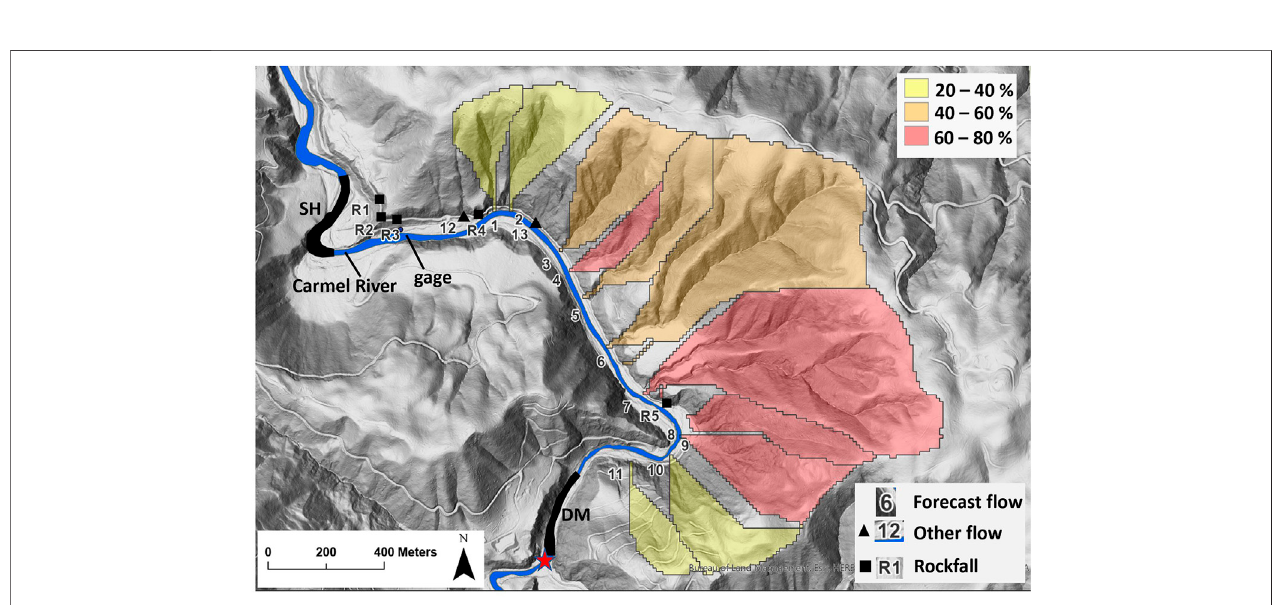
FIGURE 4 | Shaded relief map of debris fl ow study site. Eleven colored regions are watersheds with USGS debris fl ow likelihood (% chance), given a peak 15 min duration rainfall intensity of 24 mm/hr (USGS 2020). DM and SH are the long-term gravel sampling sites located upstream and downstream, respectively, of the study basins (numbers). Position of tipping bucket rain gage indicated. Red star is site of former San Clemente Dam. Carmel River fl ow is generally northward in this map.